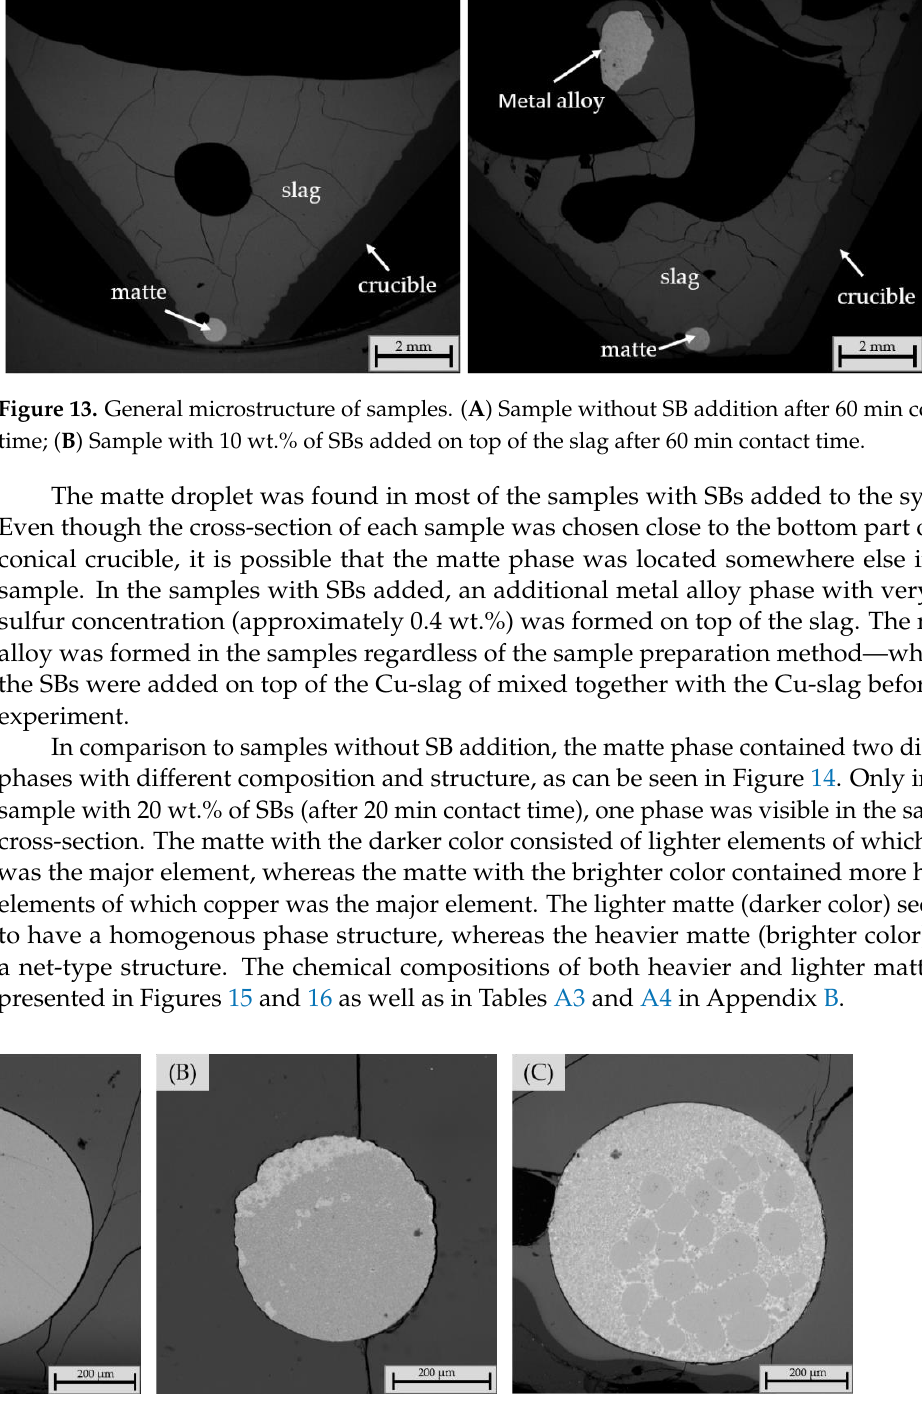
Figure 14. Matte phase formed in the system ( A ) without SBs addition; ( B ) with 10 wt.% of SBs mixed with the slag; ( C ) 10 wt.% of SBs added on top of the slag.